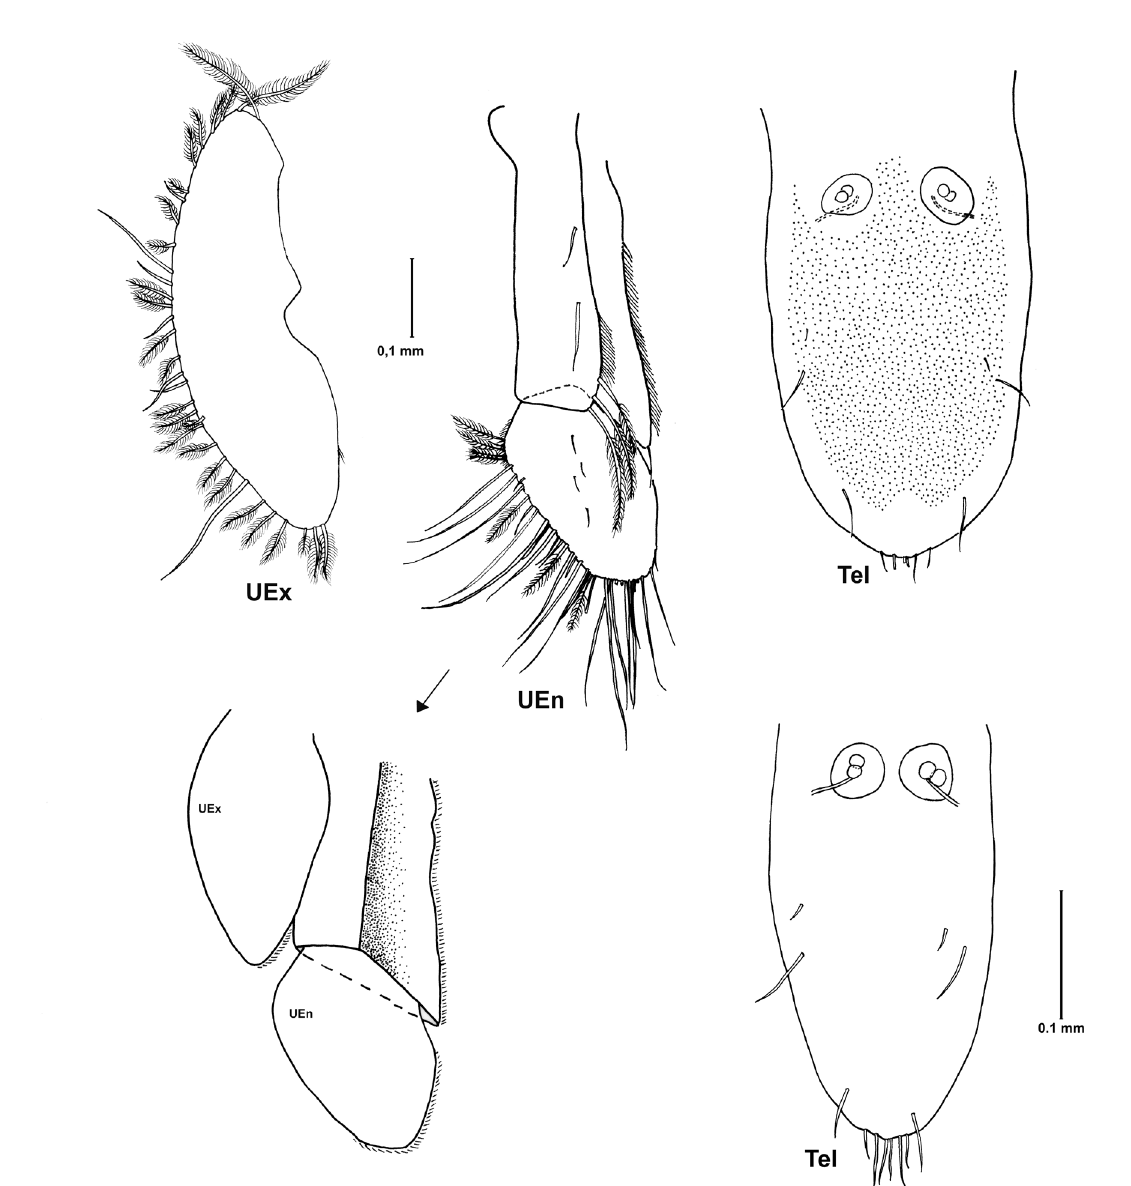
Fig. 17. Pendanthura bangkaensis sp. nov., ♀, holotype (MZB Iso 104) . Abbreviations: UEx = exopod of uropod; UEn = endopod of uropod; Tel =